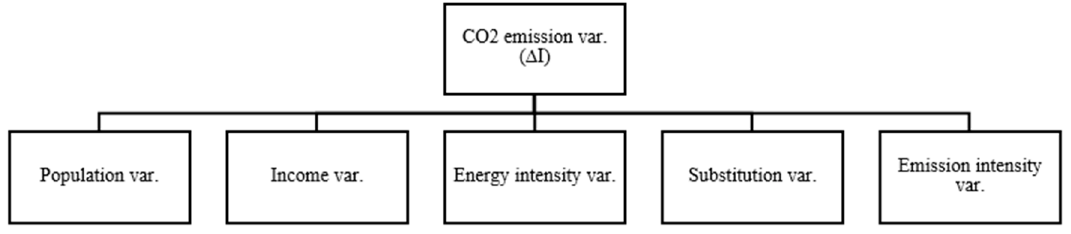
Figure 2. Decomposition flow chart.